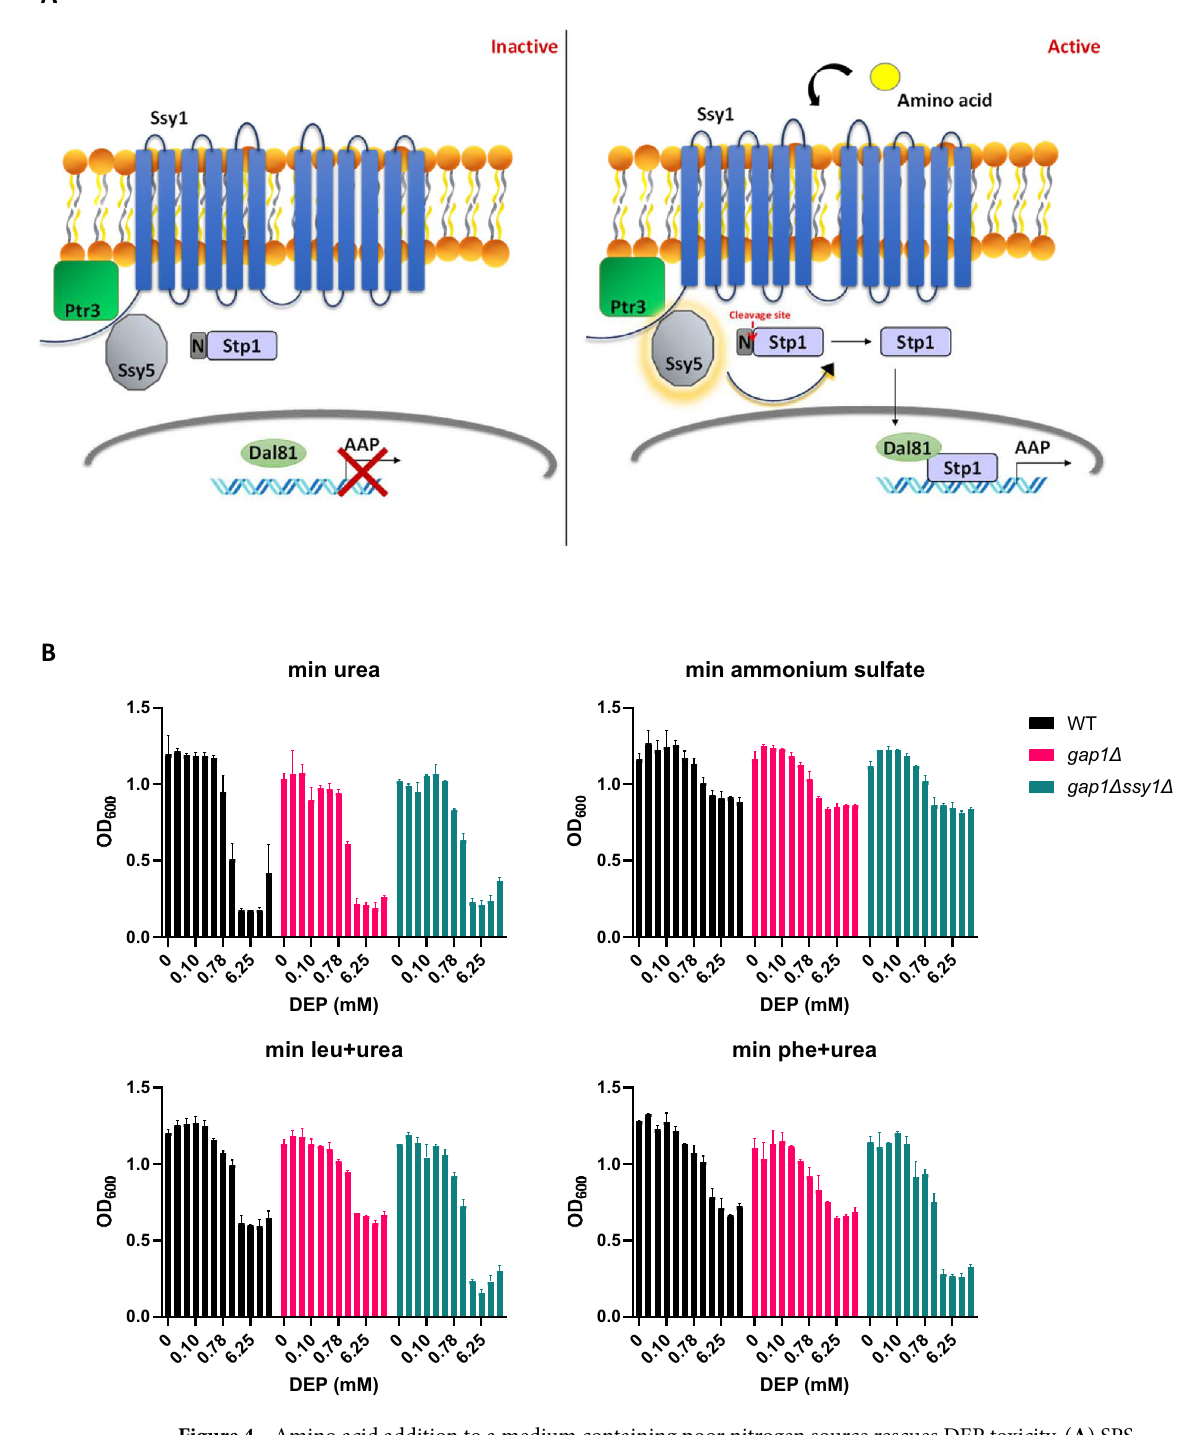
Figure 4. Amino acid addition to a medium containing poor nitrogen source rescues DEP toxicity. ( A ) SPS pathway. When amino acids are absent, SPS pathway remains inactive. Ssy5 remains inactive and does not cleave the pro-domain of Stp1, preventing the transcription of amino acid permease (AAP) genes. When amino acids are present, SPS pathway is active. Upon binding to the amino acid sensor Ssy1, Ssy5 is activated and cleaves the pro-domain of Stp1, permitting it to enter the nucleus and associate with Dal81 to induce transcription of amino acid permease (AAP) genes. ( B ) Growth inhibition of WT, gap1Δ and gap1Δ ssy1Δ (Σ1278b background) in minimal urea media with no amino acids or with 5 mM ammonium sulfate or phenylalanine, or leucine. Error bars indicate standard deviation ( N = 2). Each consecutive bar represents a doubled concentration of the preceding bar, with 25 mM as the maximal concentration used for